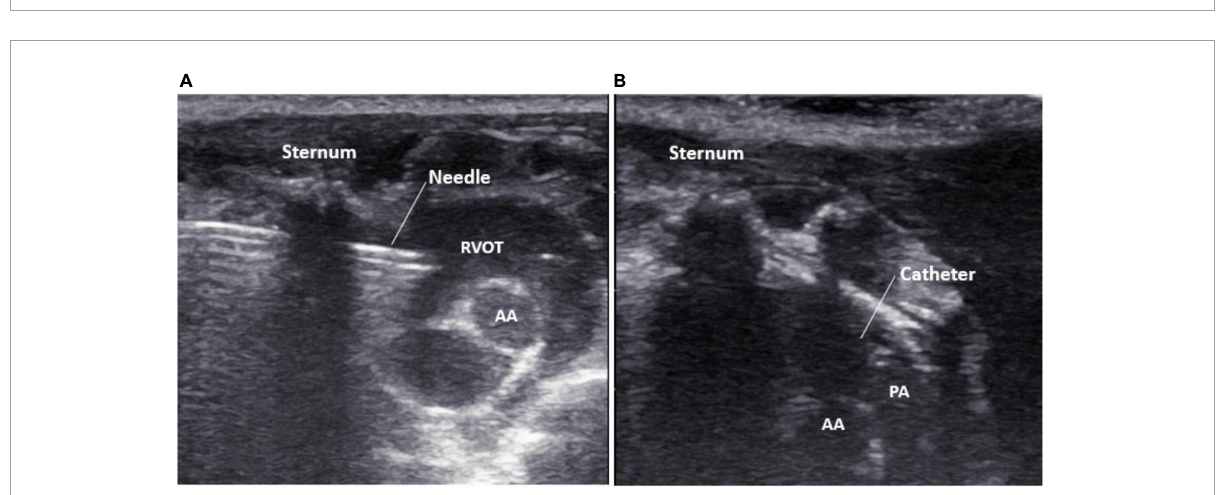
FIGURE3 Real-time display of needle tip guided by high-frequency ultrasound. (A) The puncture needle tip is located in the right ventricular outflow tract; (B) the catheter tip is located in the pulmonary artery. PA, pulmonary artery; AA, aorta; RVOT, right ventricular outflow tract.